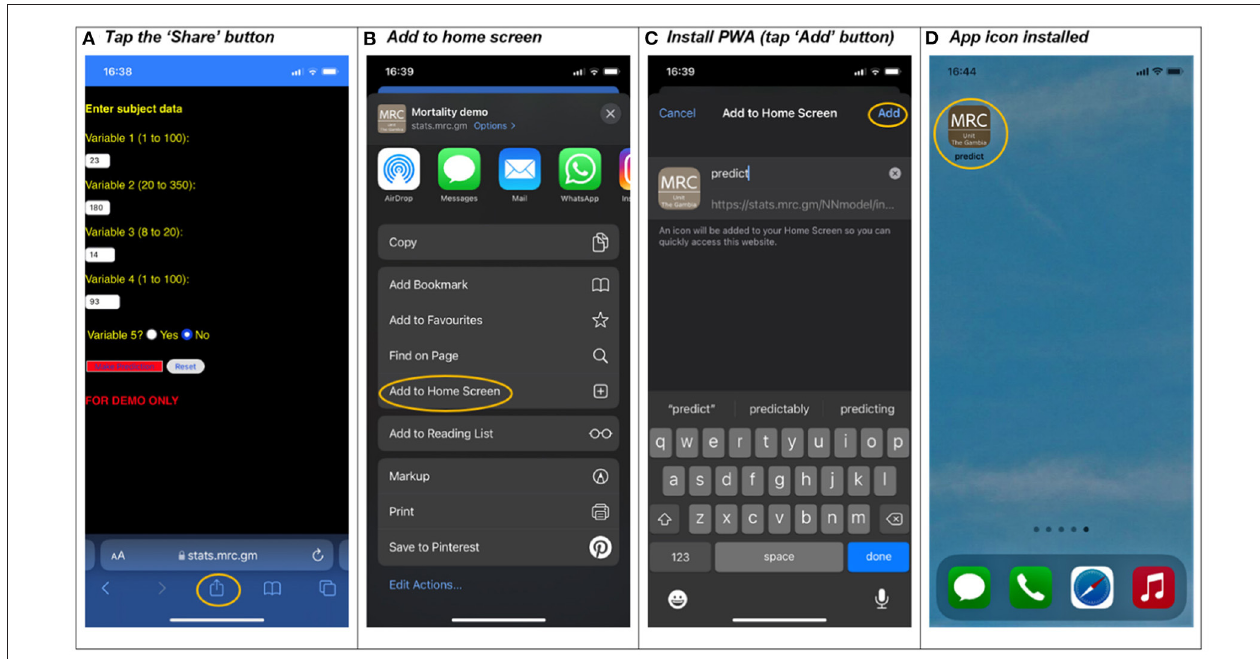
FIGURE 3 | Installing a PWA application on an iOS